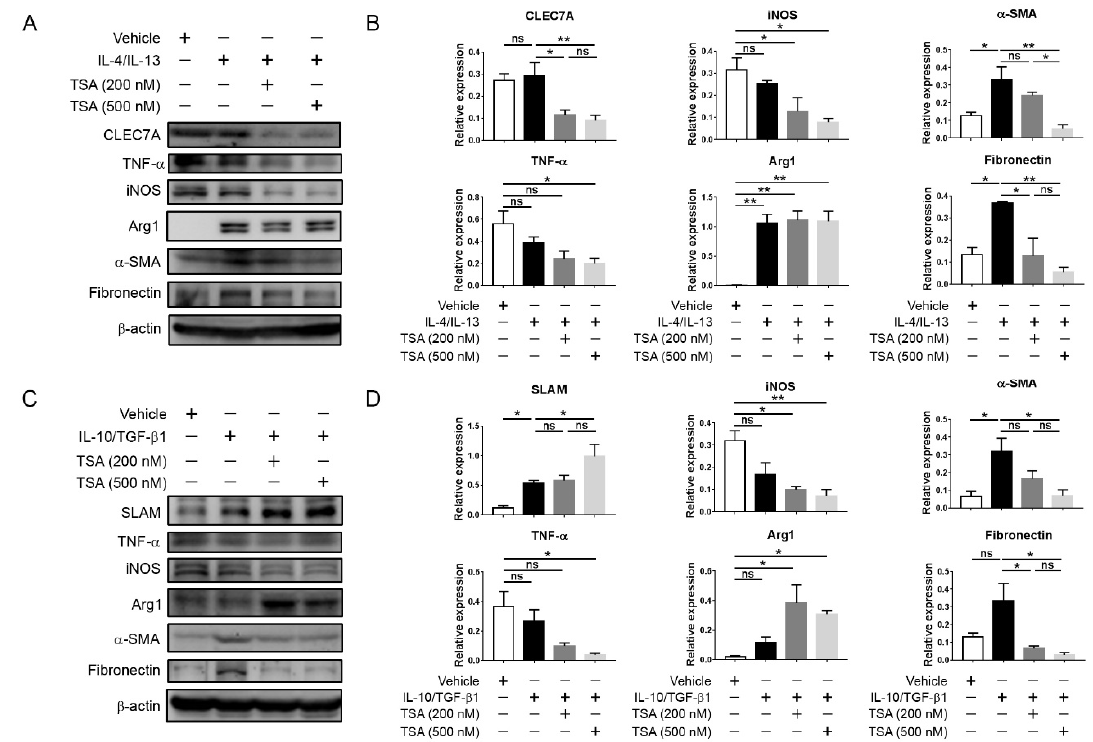
Figure 5. The effect of trichostatin A (TSA) on proinflammatory and profibrotic phenotypes of M2a and M2c macrophages. ( A ) Western blots of C-type lectin domain family 7 member A (CLEC7A), proinflammatory (tumor necrosis factor- α (TNF- α ) and inducible nitric oxide synthase (iNOS)) and profibrotic ( α -smooth muscle actin ( α -SMA) and fibronectin) expressions in J774A.1 macrophages treated with the indicated conditions for 24 h. Concentrations of interleukin (IL)-4 and IL-13 were both 20 ng / mL. β -actin served as the loading control. ( B ) Quantification for the levels of indicated proteins. * p < 0.05 and ** p < 0.01 by ANOVA, followed by Tukey’s post hoc multiple comparison test; n = 3 for each group. ( C ) Western blots of SLAM, proinflammatory (TNF- α and iNOS) and profibrotic ( α -SMA and fibronectin) expressions in J774A.1 macrophages treated with the indicated conditions for 24 h. Concentrations of IL-10 and transforming growth factor (TGF)- β 1 were both 20 ng / mL. β -actin served as the loading control. ( D ) Quantification for the levels of indicated proteins. * p < 0.05 and ** p < 0.01 by ANOVA, followed by Tukey’s post hoc multiple comparison test; n = 3 for each group.